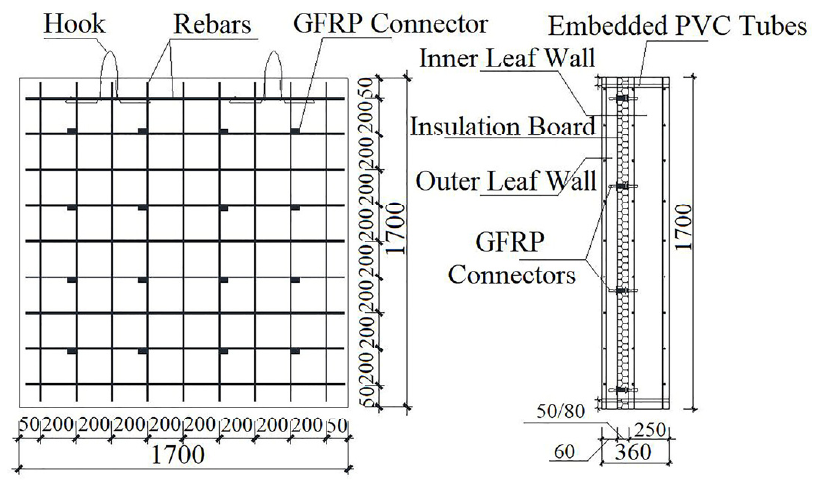
Figure 3. The SIW wall panel reinforcement.